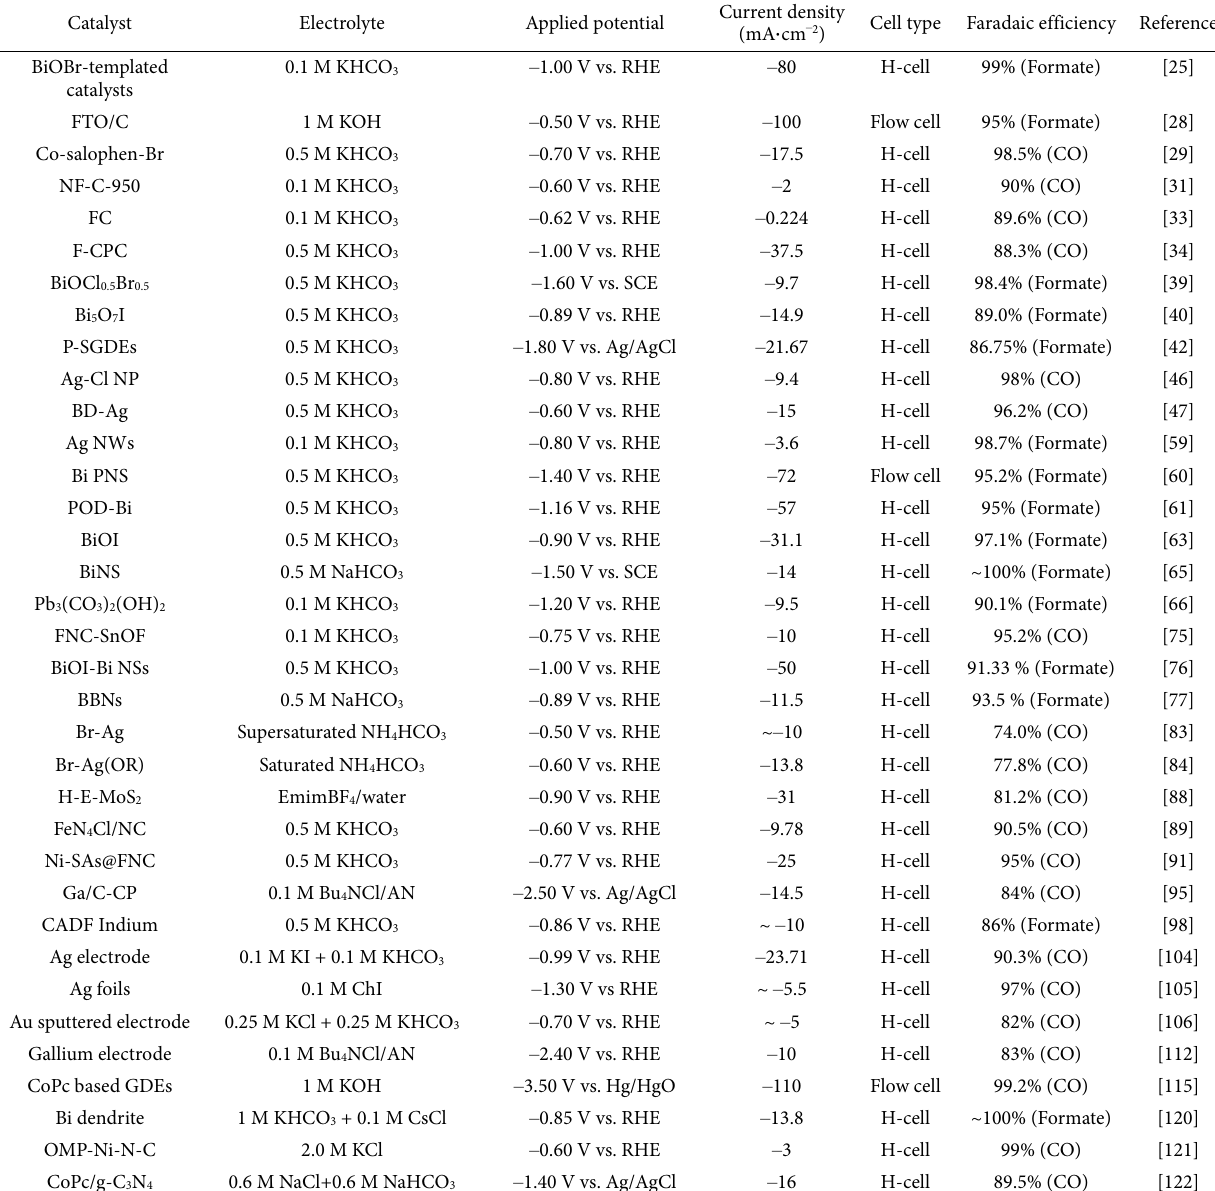
Table 2 Comparison of electrochemical performance of various catalysts for formate or CO products Catalyst Electrolyte Applied